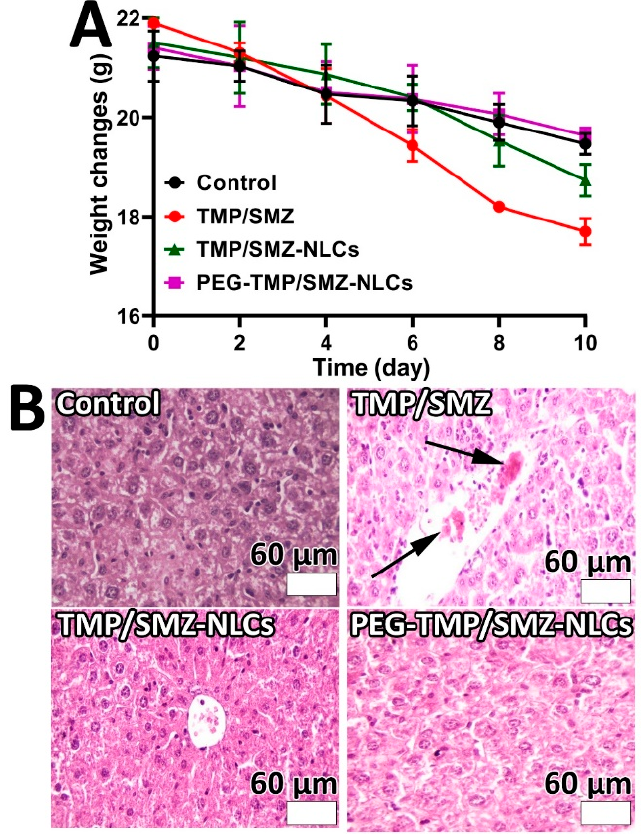
Figure 7. ( A ) Weight change measurements in MRSA skin infections in Balb/c mice 10 days after the development of infection. As the figure shows, TMP/SMZ receiver mice, compared to TMP/SMZ- NLCs, PEG-TMP/SMZ-NLCs receiver, and the control groups of mice, demonstrated higher weight loss. ( B ) Histopathological effects of (i) TMP/SMZ, (ii) TMP/SMZ-NLCs, and (iii) PEG-TMP/SMZ- NLCs, compared to (iv) PBS, on the liver of the skin-infected mice caused by MRSA. Arrows show the histopathological lesion (Magnification ×40).